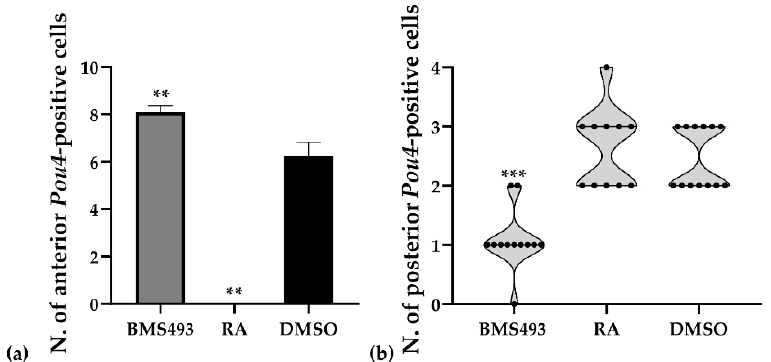
Figure 7. Effects of retinoic acid (RA) signaling manipulation on the number (N.) of cells expressing Pou4 in the nerve cord anterior and posterior to the first pigment spot at the T1 stage. ( a ) The average number of Pou4 -positive cells in the nerve cord anterior to the first pigment spot is indicated by bars and the standard deviation by error bars. ( b ) The number of Pou4 -positive cells posterior to the first pigment spot is presented in the form of a violin plot with each dot representing a specimen. DMSO, treatment control ( n = 13); BMS493, RA signaling inhibition with an inverse agonist ( n = 12); RA, RA signaling activation with all- trans retinoic acid ( n = 11); **, p < 0.01; ***, p < 0.001.